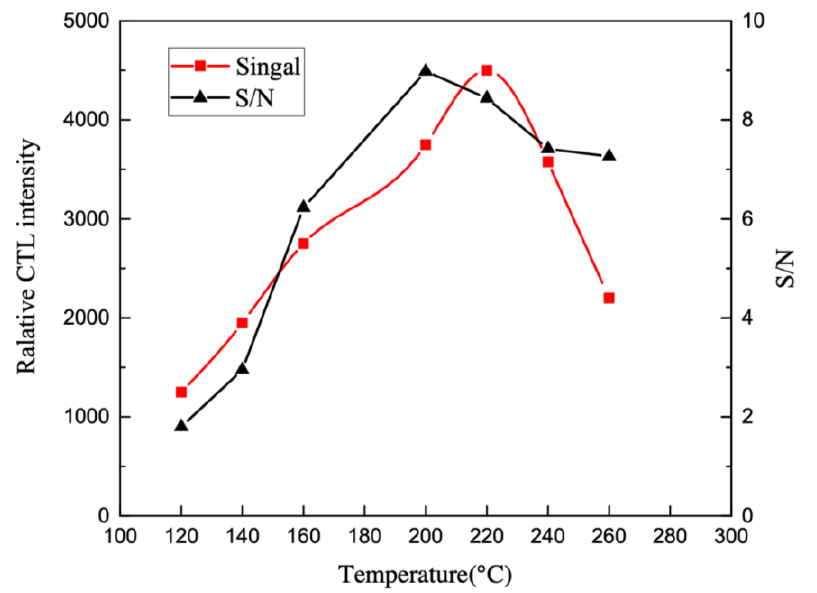
Figure 6. The luminescence intensity of acetone changed with different wavelengths (temperature: 220 °C, flow rate: 310 mL/min, concentration: 500 ppm).